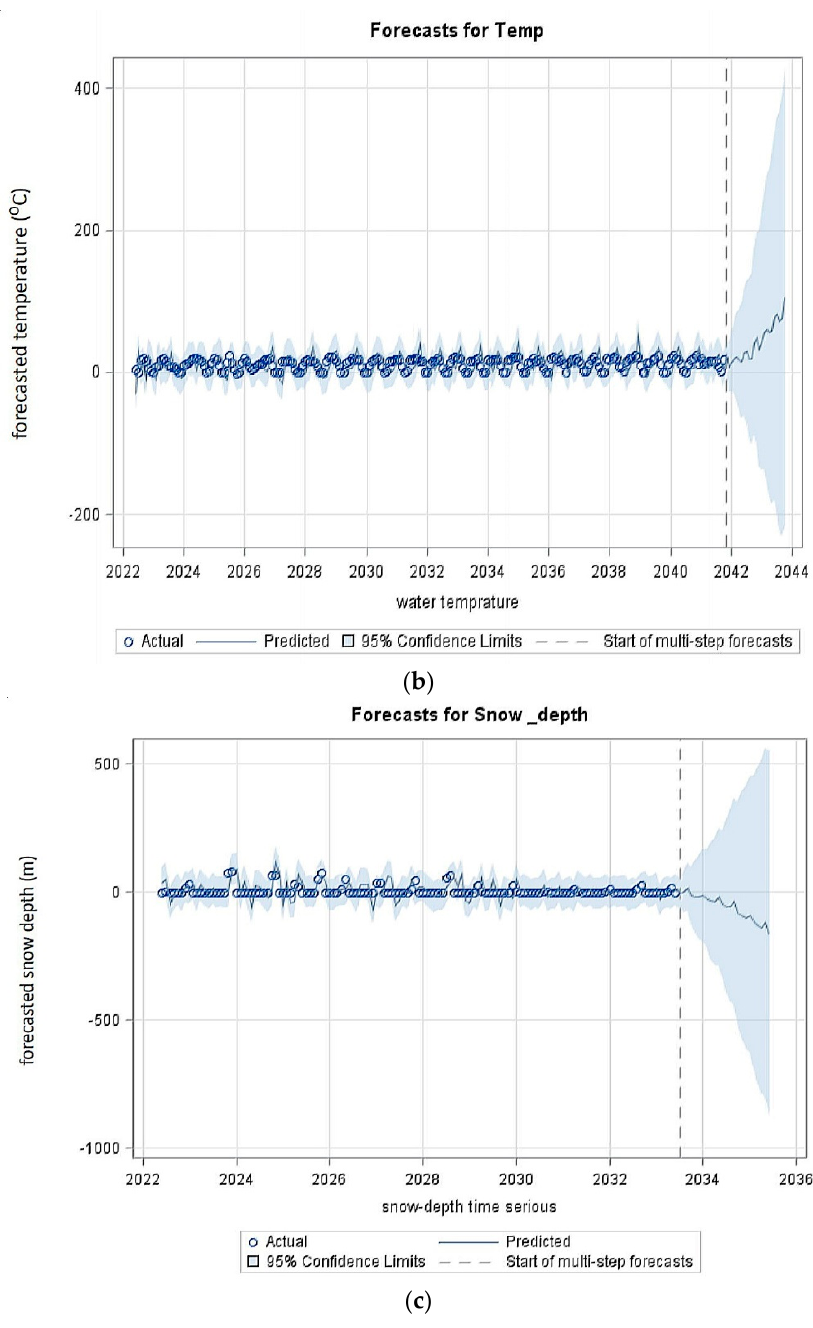
Figure 4. ARIMA analysis of the ( a ) forecasting of the air temperature from 2022 to 2044, ( b ) water temperature forecast from 2022 to 2044, and ( c ) forecasting of the snow depth from 2022 to 2036 in the Vaasa Airport weather station.